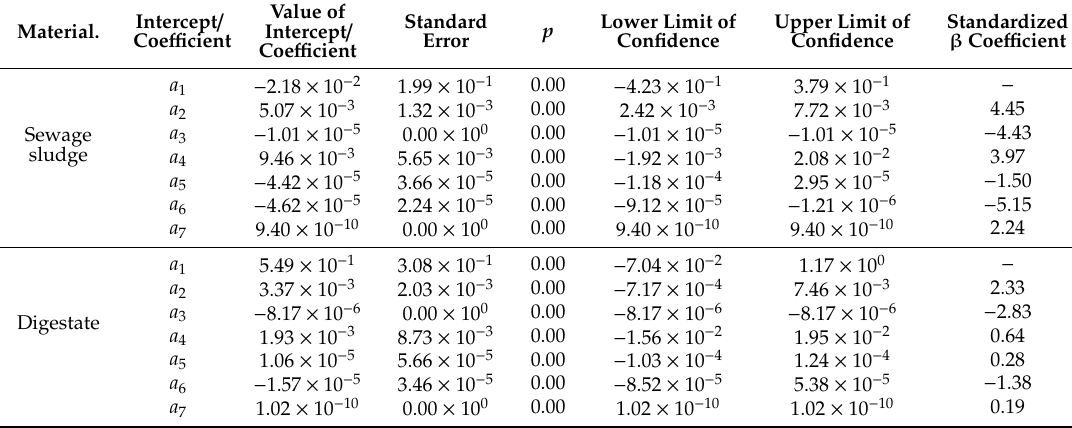
Table A4. Statistical evaluation of model coe ffi cients for the OM content in CSF from sewage sludge and digestate. Material.